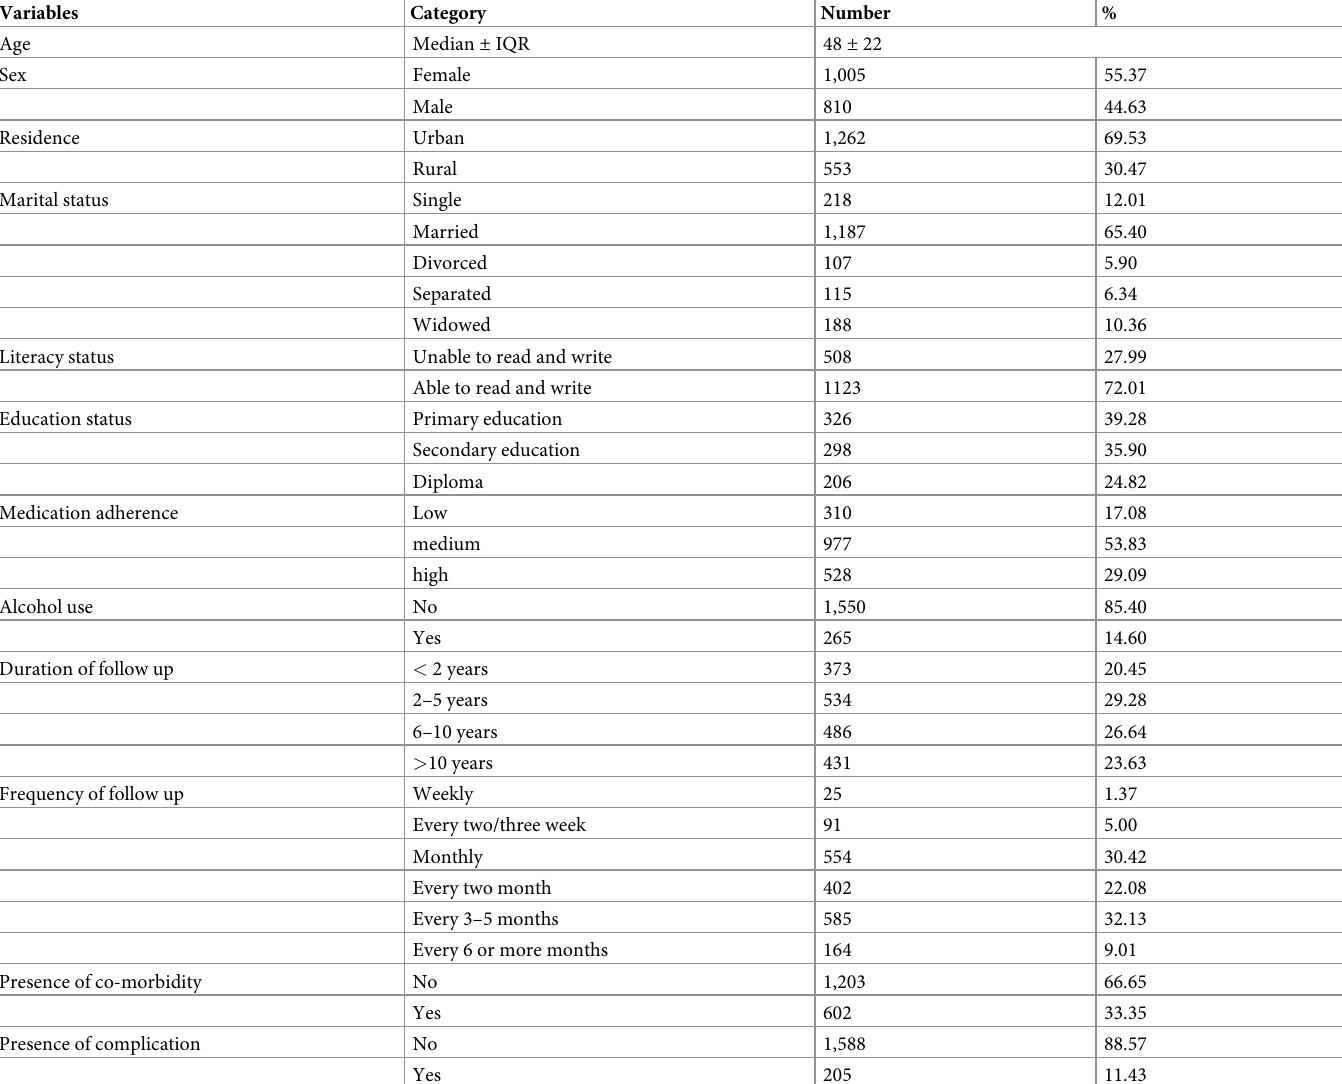
Table 1. Background characteristics of patients with common chronic disease in Amhara region, Ethiopia,